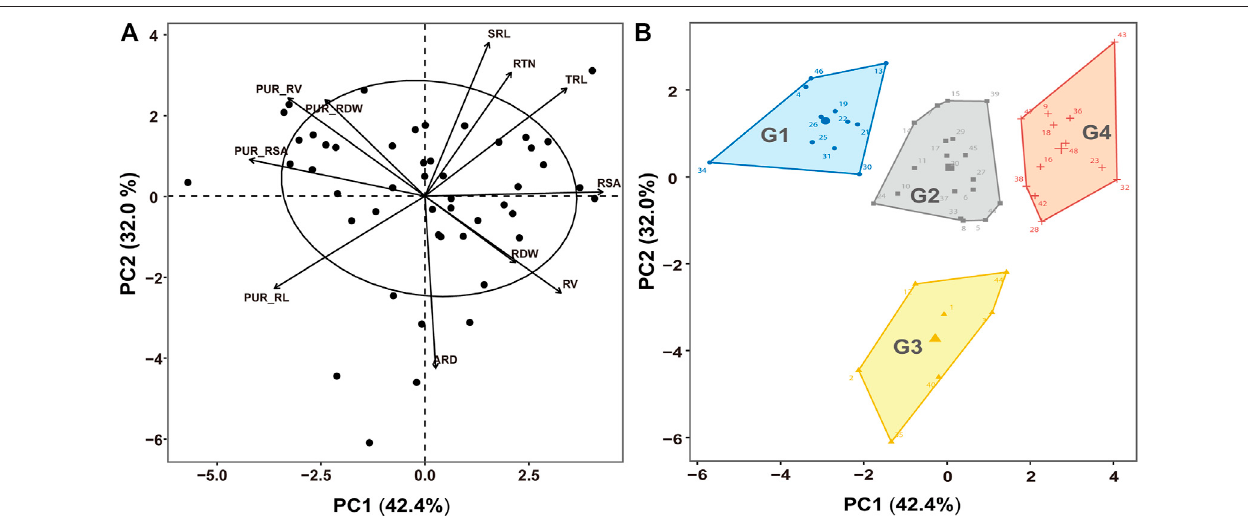
FIGURE 6 | Principal component analysis (PCA) of P absorption ef fi ciency traits and root traits under low-P (LP) treatment. (A) Variable covariance along with the fi rst two components and (B) clusters formed with hierarchical classi fi cation on principal components (HCPC). RDW, root dry weight per plant; TRL, total toot length; RSA,rootsurfacearea;RV,rootvolume;ARD,averagerootdiameter;RTN,roottipnumber;SRL,speci fi crootlength;PUR_RDW,Puptakerateperunitrootdryweight; PUR_RL, P uptake rate per unit root length; PUR_RSA, P uptake rate per unit root surface area; PUR_RV, P uptake rate per unit root